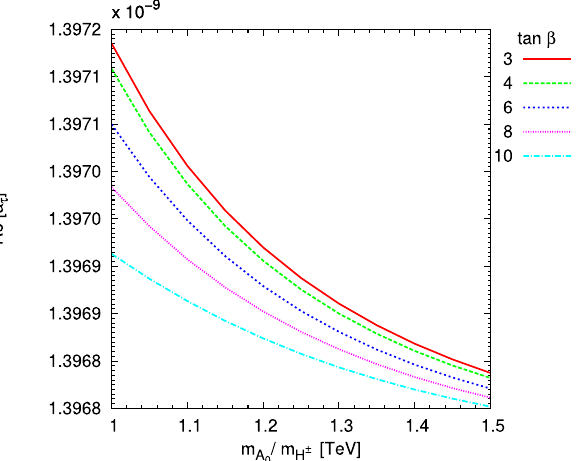
Fig. 6 Total contribution to Re ( a τ ) for different values of tan β . The plot is obtained with fixed values of the f = 1000 GeV and F = 4000 GeV. The values provided in Table 3 are used for the remaining parameters of the